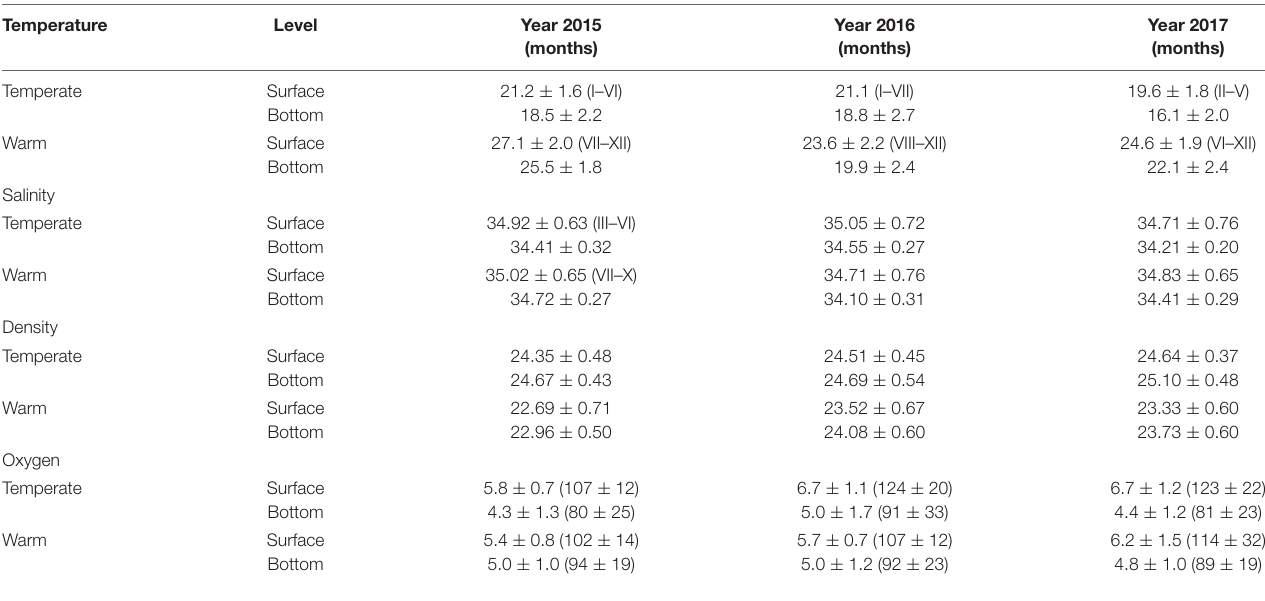
TABLE 1 | Average values and standard deviation of temperature ( ◦ C), salinity, density (kg l − 1 ), and dissolved oxygen (ml l − 1 and saturation value %) per season of the year and depth level.